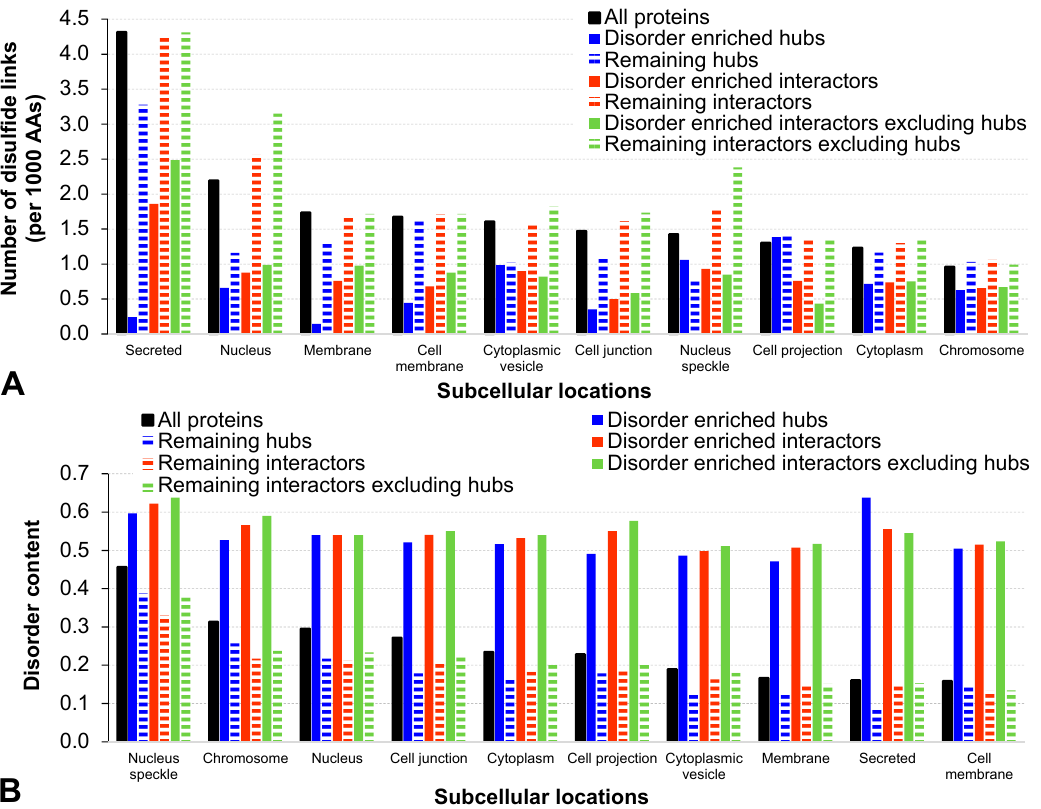
Figure 2. Number of disulfide bonds panel ( A ) and disorder content panel ( B ) in specific subcellular locations. We report the values for all human proteins (black bars), hubs (solid blue), hub interactors (solid red), and hub interactors that exclude hubs (solid green) that are associated with the disorder-enriched hub PPIs vs the remaining hubs (blue horizontal stripes), hub interactors (red horizontal stripes), and hub interactors that exclude hubs (green horizontal stripes), respectively, for each location. We consider all locations that include at least 10 proteins for each of the seven protein sets. The locations in panel ( A , B ) are sorted in descending order by the values of the number of disulfide bonds (disorder content) for all proteins (black bars).